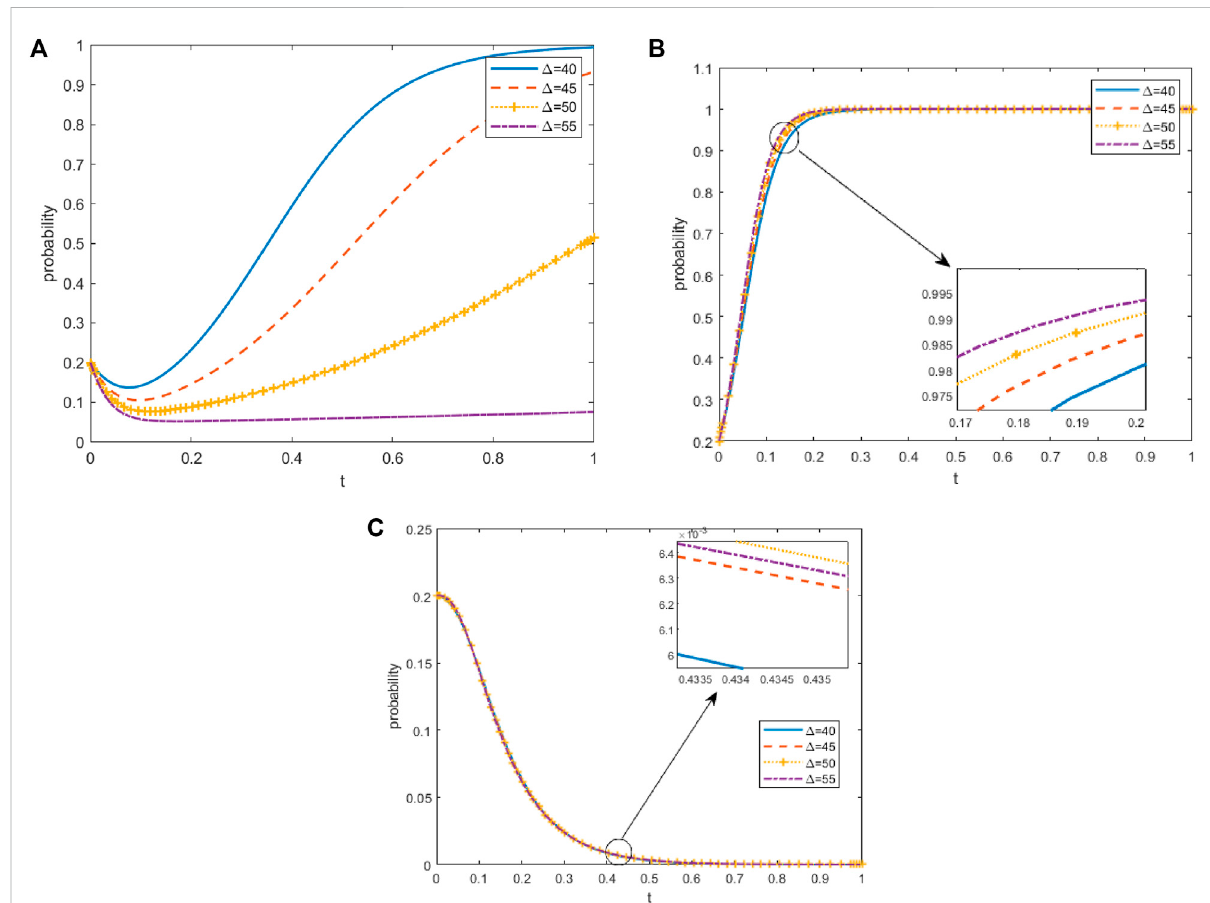
FIGURE 11 Effectof Δ ontheevolutionofthesystem. (A) Effectof Δ onfarmer ’ sstrategy, (B) Effectof Δ onthelocalgovernment ’ sstrategy, (C) Effectof Δ on the central government ’ s